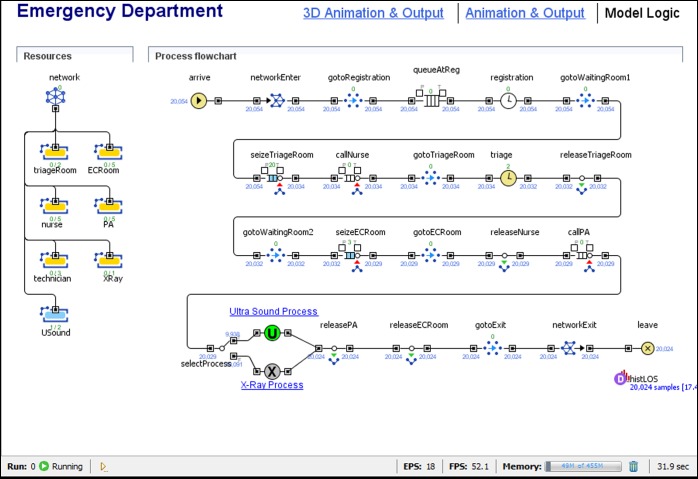
A discrete event simulation model of an emergency department (AnyLogicTM).